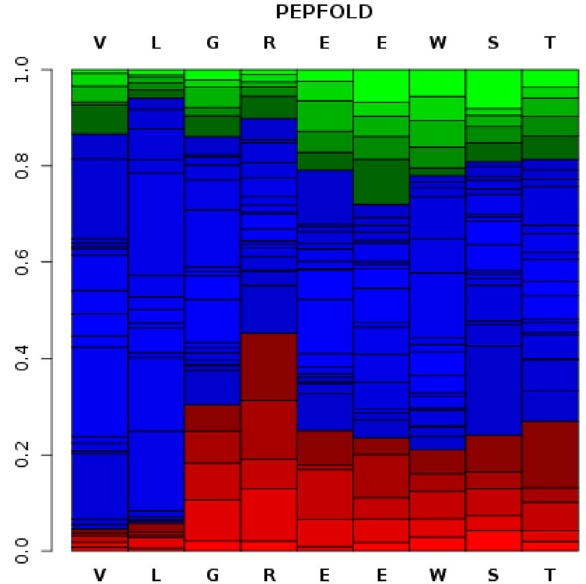
Figure 7. De novo conformation prediction for the VLGREEWSTSYW peptide. The de novo conformation of the VLGREEWSTSYW peptide shows variable possibilities for each amino acid residues to attain a secondary structure: α-helix (red), coil (blue), and extended conformation